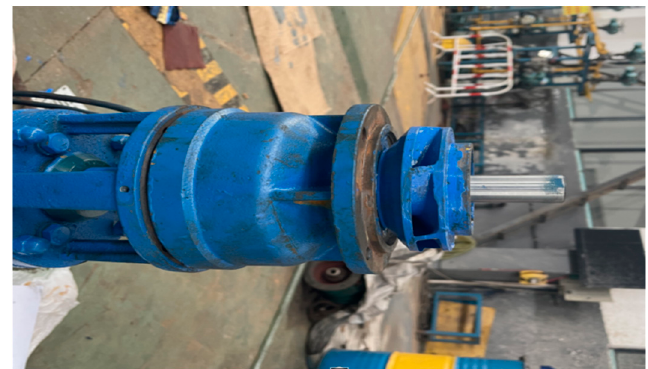
Figure 23. Test system diagram. 1—Test pump (including motor); 2—Test pump support mecha- nism; 3—Flow meter; 4—Outlet pipe; 5—Return pipe; 6—Regulating valve; 7—Return pipe support member; 8—Cable terminal; 9—Cable fixing component; 10—Water tank; 11—Anti-submersible pump swing component.